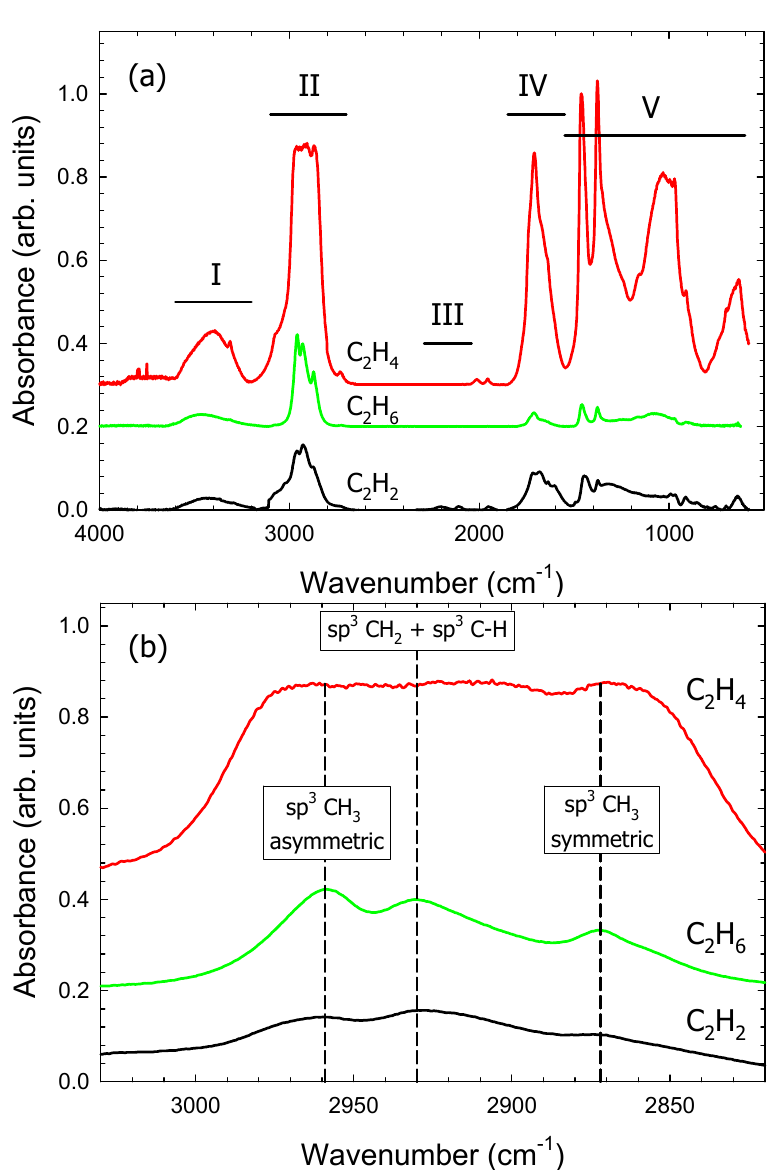
Figure 2. ( a ) FTIR spectra of a-C:H films obtained from C 2 H m /Ar ( m = 2, 4, 6) gas mixture, (gas pressure = 300 mbar, gas ratio = 1:2, power = 4 W). To ease comparison, the data obtained with C 2 H 6 /Ar and C 2 H 4 /Ar are shifted upwards by 0.2 and 0.3, respectively; ( b ) Magnification of the FTIR region 3030–2820 cm − 1 . For comparison, the data obtained with C 2 H 6 /Ar and C 2 H 4 /Ar are shifted upwards.